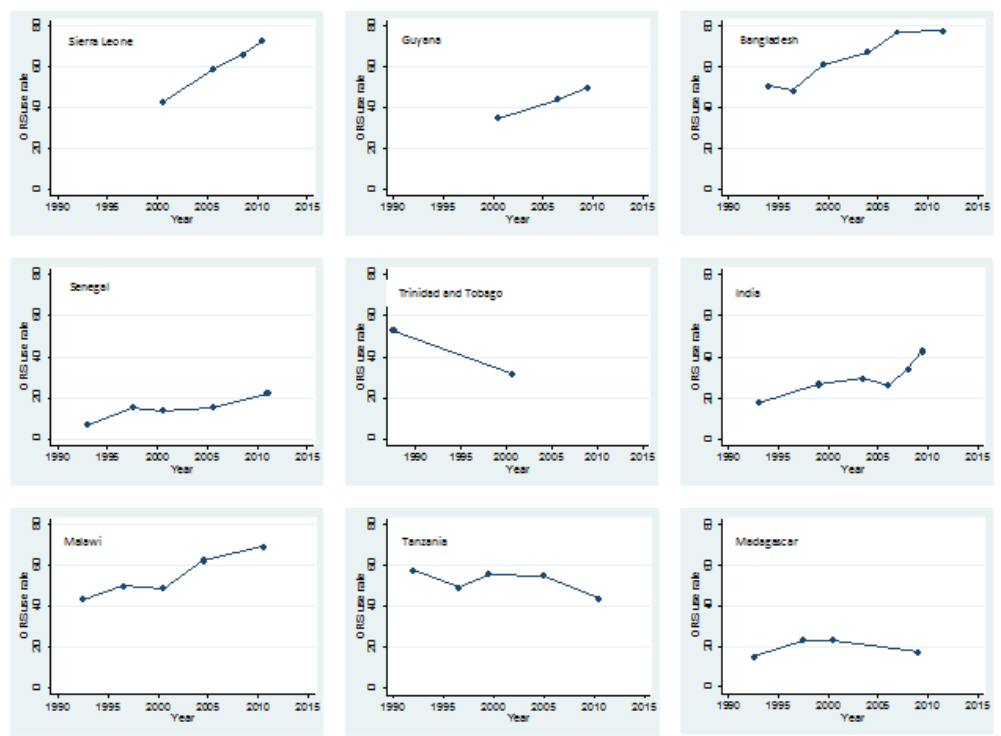
Figure 2. Oral rehydration solution (ORS) use rates by country,